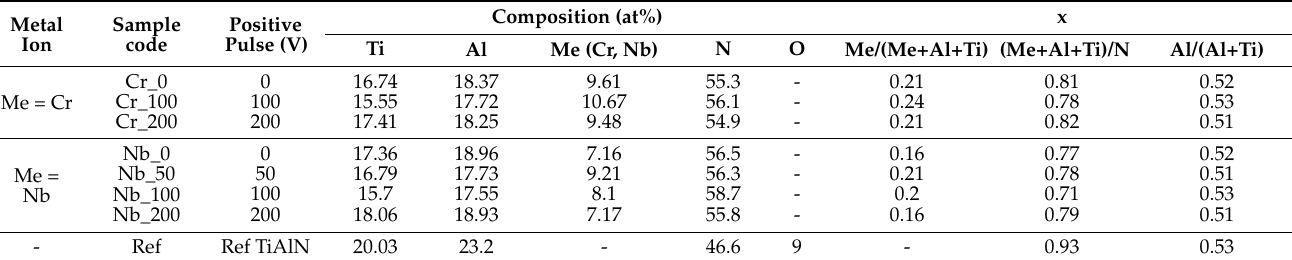
Table 1. Atomic composition of the (TiAl) 1 − x (Cr,Nb) x N